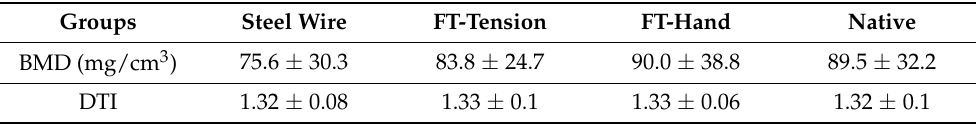
Table 1. Mean bone mineral density (BMD) and deltoid tuberosity index (DTI) over all groups.